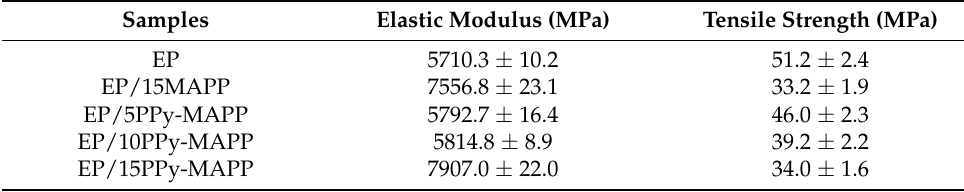
Table 5. Mechanical property parameter of pure EP and EP composites.